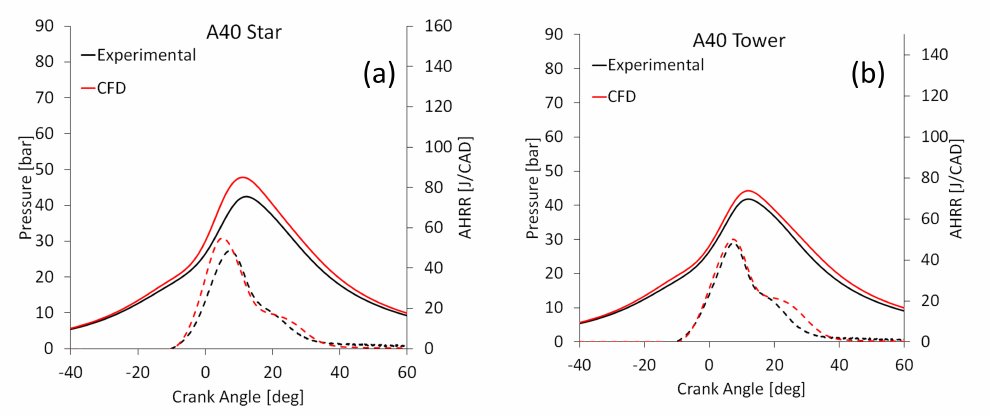
Figure 16. Comparison between the computed and experimental data of the in-cylinder pressure (solid lines) and apparent heat release rate (dashed lines) for the A40 operating point when using the star ( a ) and tower ( b ) pistons.